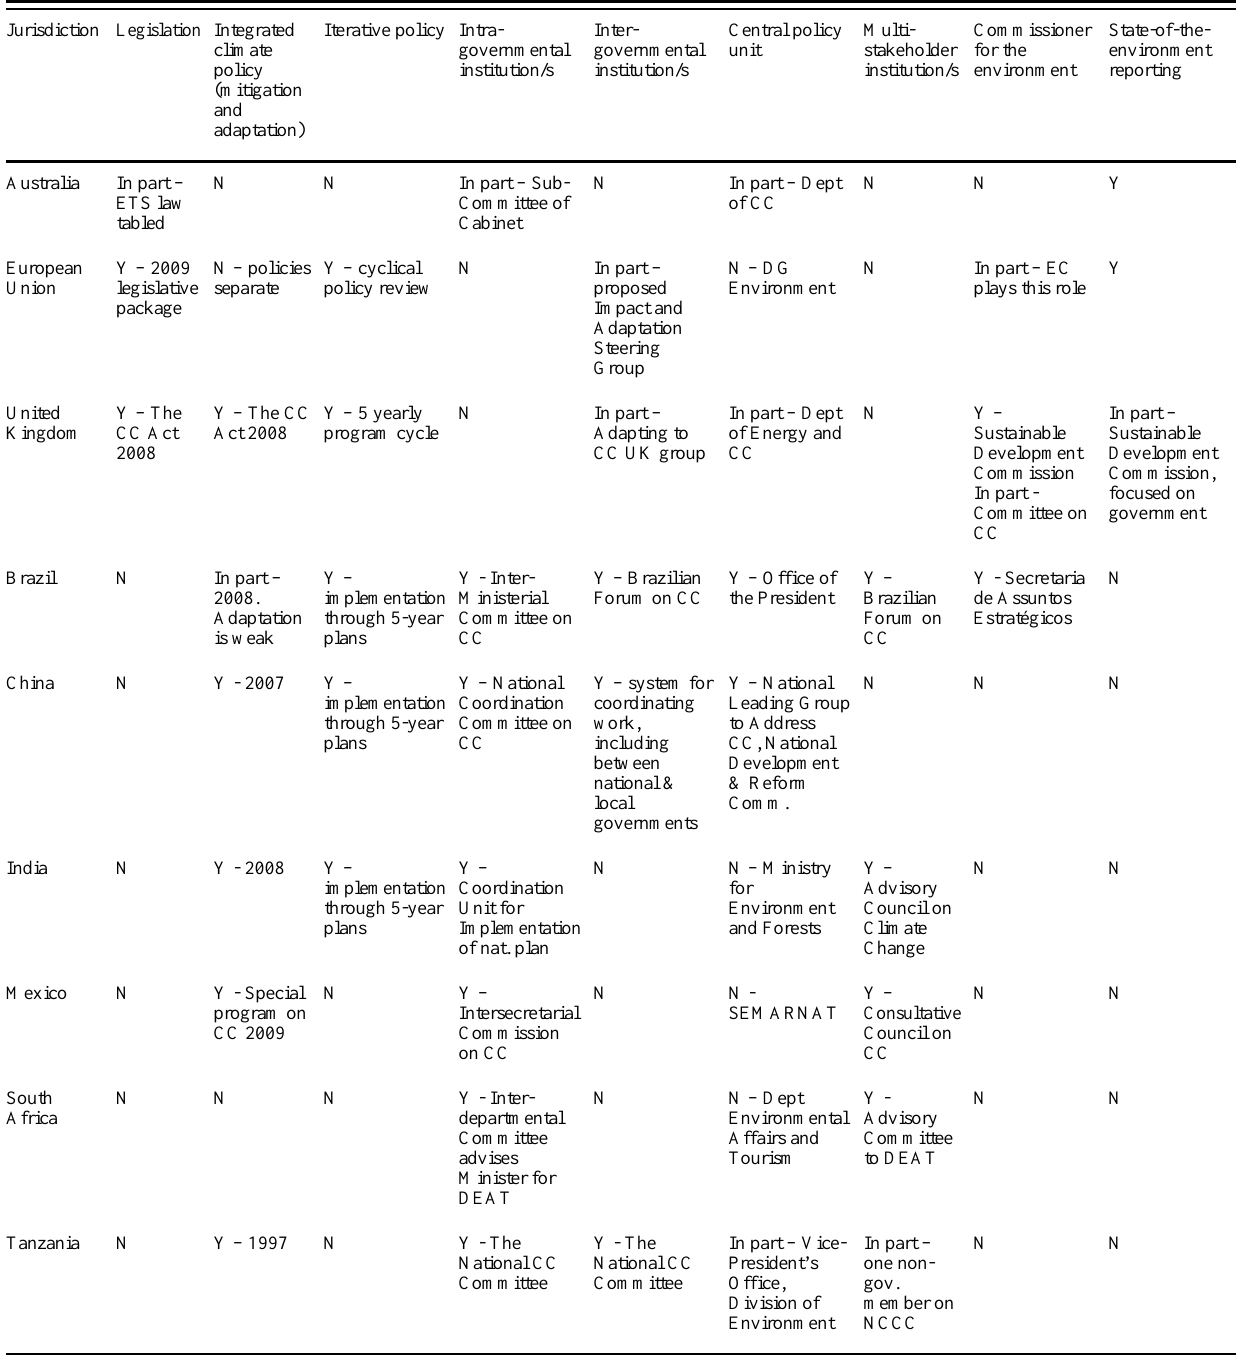
Table 4. Climate policy institutional settings Note: CC= climate